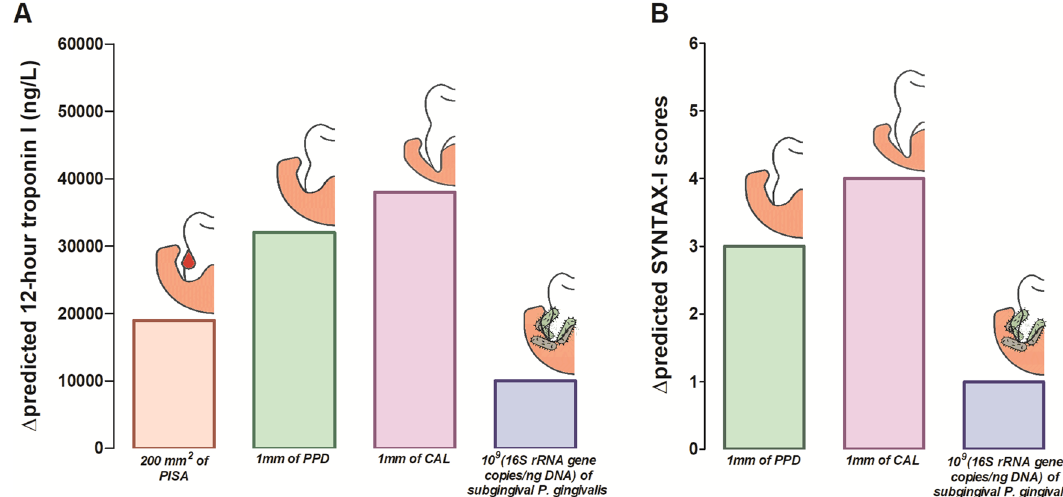
Figure 1. Change in the predicted ( A ) 12-h Troponin I, ( B ) SYNTAX-I scores, with worsening markers of periodontitis and P. gingivalis load. ( A ) the incremental effect of three clinical indicators of periodontitis (PISA, mean-PPD, mean-CAL) and subgingival P. gingivalis load on 12-h Troponin I levels, ( B ) incremental effect of mean-PPD, mean-CAL and subgingival P. gingivalis load on SYNTAX-I score. PISA periodontal inflamed surface area, PPD probing pocket depths, CAL clinical attachment